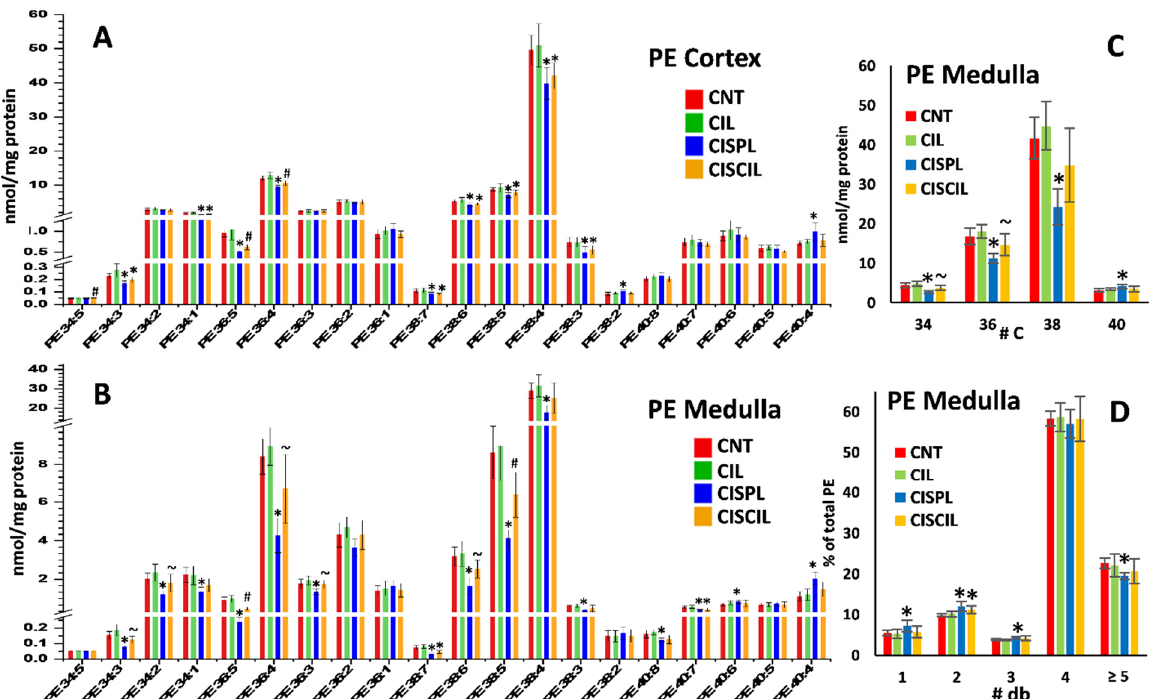
Figure 6. Phosphatidylethanolamine (PE) species found in the renal ( A ) cortex and ( B ) medulla in CNT, CIL, CISPL, and CISCIL groups. The amount of PE species containing different total length of fatty acid chains ( C ) and percentage of PE species containing different double bonds ( D ) are presented in medulla. * p < 0.05 vs. CNT. ~ p < 0.05 vs. CISPL. # p < 0.05 vs. CNT and CISPL. FDR < 0.1 was considered. Data are presented as the mean ± sd; n = 6 animals per group.